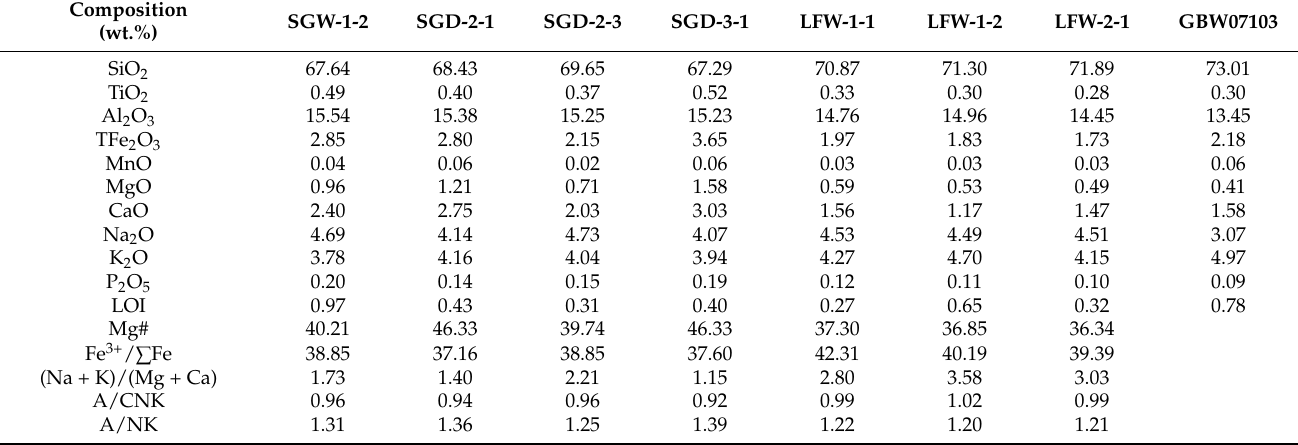
Table 1. Major element compositions of of Shangcheng adakitic